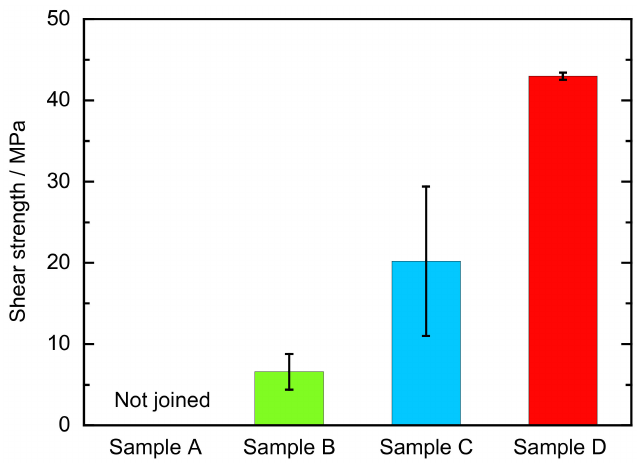
Figure 5. Measurement results for shear